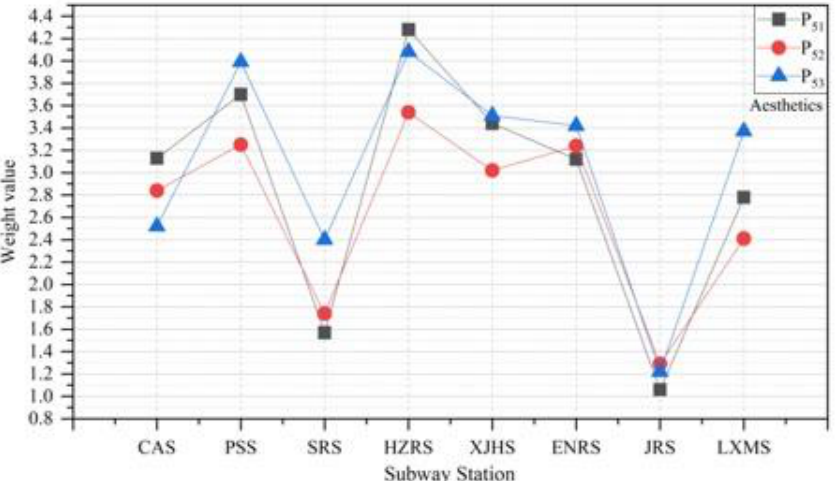
Figure 16. The evaluation results of the aesthetic evaluation index of transfer space environments at sample stations.